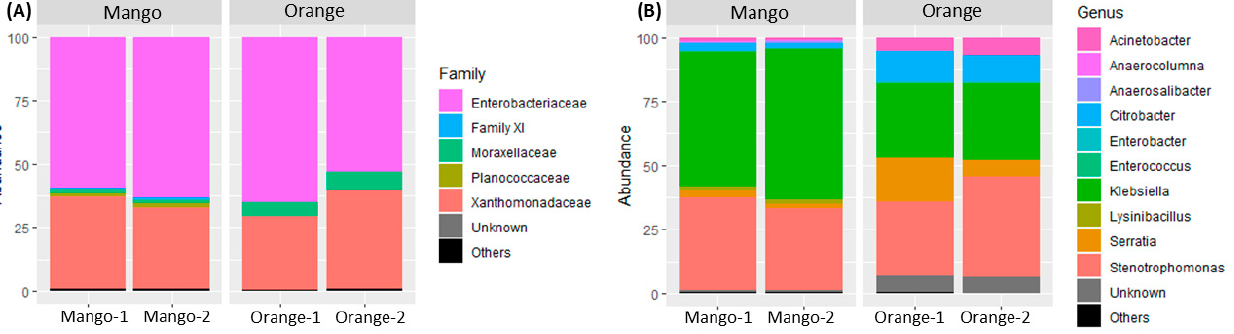
Figure 2. Taxonomic profile of the microbiota present in the enriched Mango and Orange samples analyzed by 16S rRNA gene sequencing by relative abundance (%): ( A ) family level and ( B ) genus level. Data were normalized from the sample with the lowest number of reads.